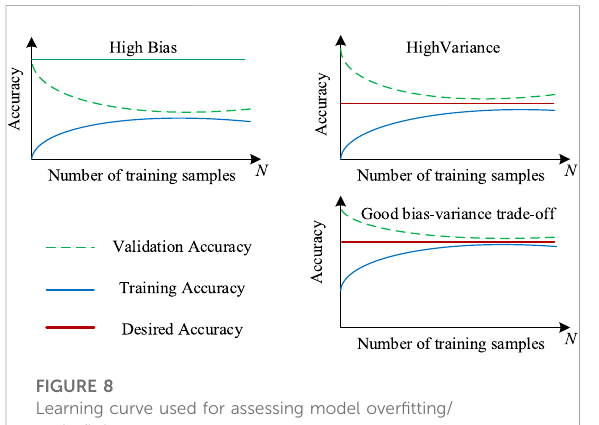
FIGURE 8 Learning curve used for assessing model over fi tting/ under fi tting.